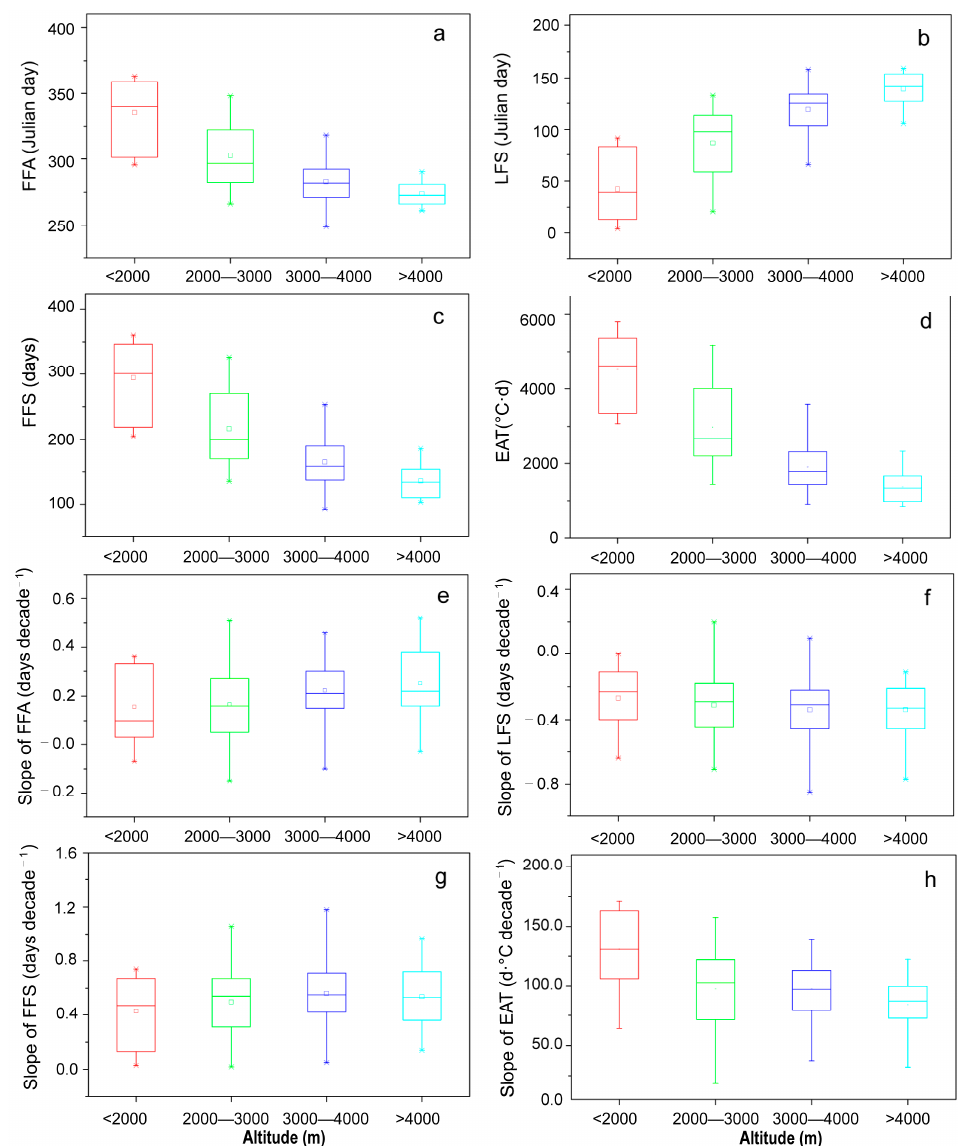
Figure 3. Statistical analysis of the first and last frost days and frost-free periods and their change rates in different altitude ranges on the Qinghai–Tibetan Plateau. a–d represent annual mean values of FFA, LFS, FFS and EAT in different altitude ranges; e–h represent annual change rates of FFA, LFS, FFS and EAT in different altitude ranges. Note: The upper, middle and lower lines in the box indicate the upper quartile, median and lower quartile values of climatic factors and their change rates at all stations in each accumulated temperature range, respectively. The – above and below indicates the maximum and minimum values, × on and above and below indicates the 1% and 99% values, and (cid:3) represents the mean value at all